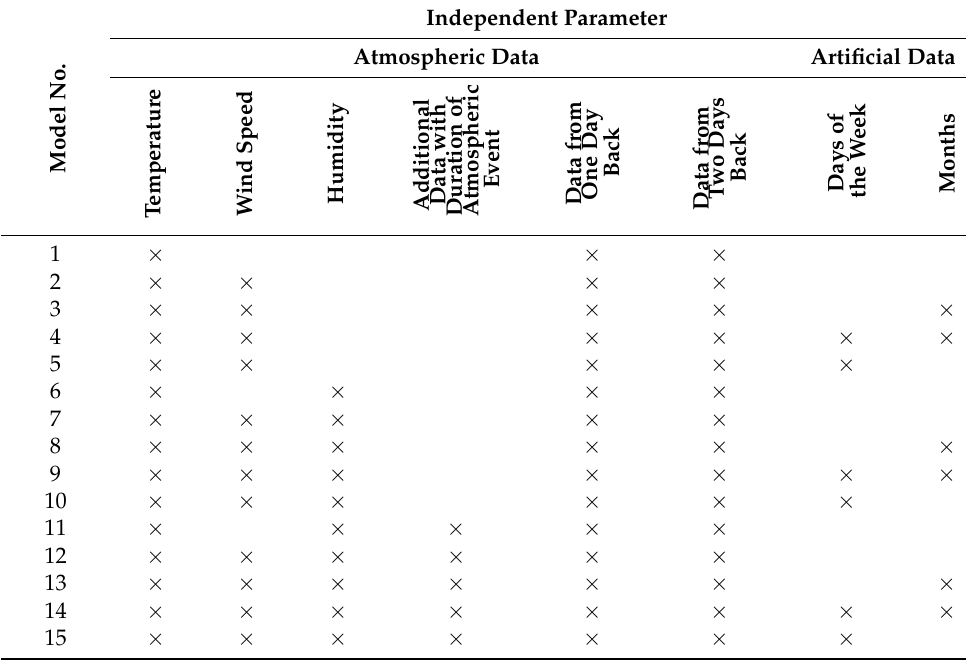
Table 3. Data ranges used to calculate the best model. Temperature: daily average, min/max, or at ground level with data from 2 days back.